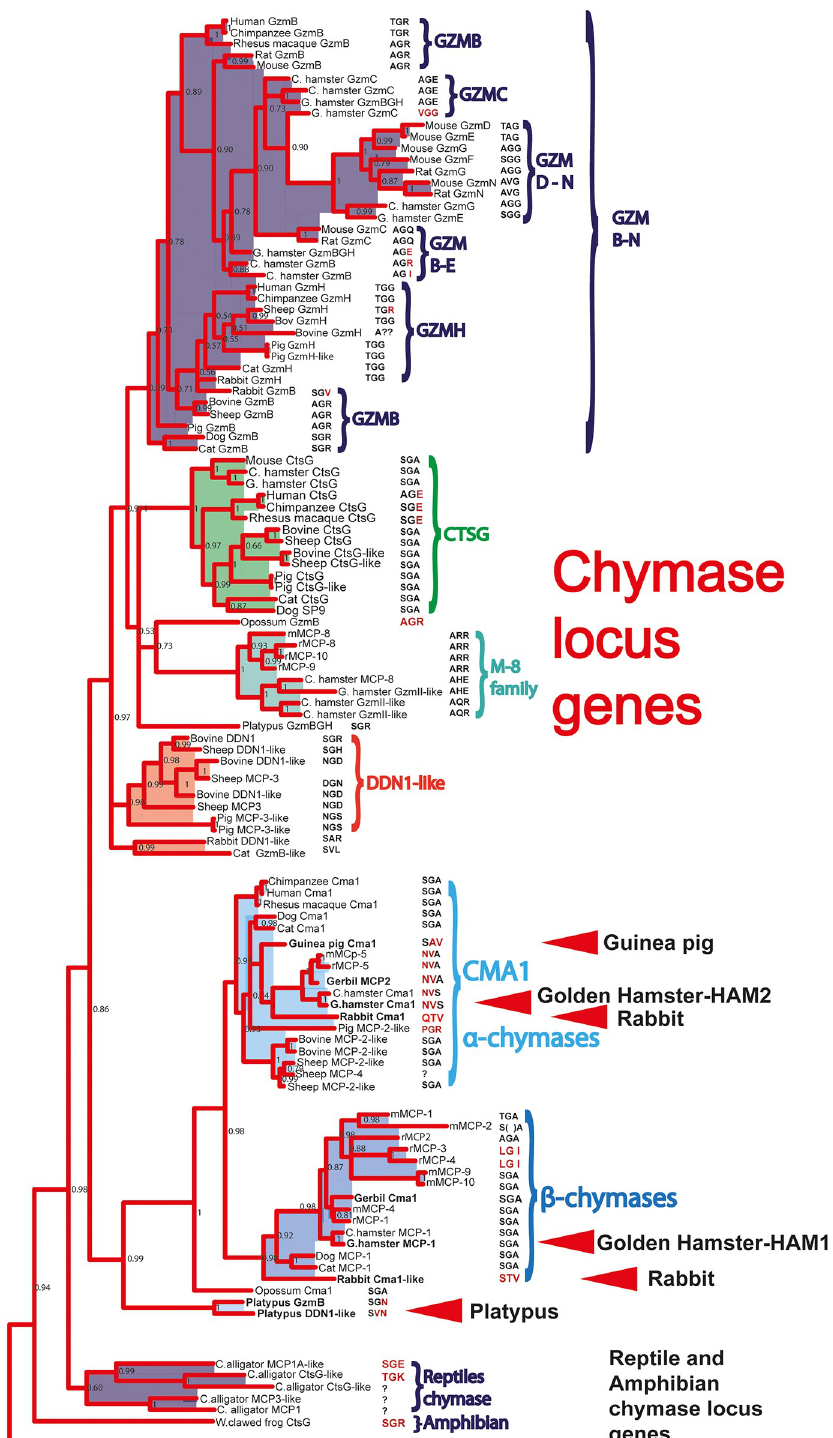
Fig 1. Phylogenetic tree of serine proteases encoded from the chymase locus in vertebrate species. A panel of vertebrate chymase locus encoded genes were analyzed for their sequence relatedness using the MrBase analysis program and the Maximum-likelihood algorithm [6]. The major enzyme clusters are marked by brackets and their names. The genes of particular interest for this study are marked with red arrows.